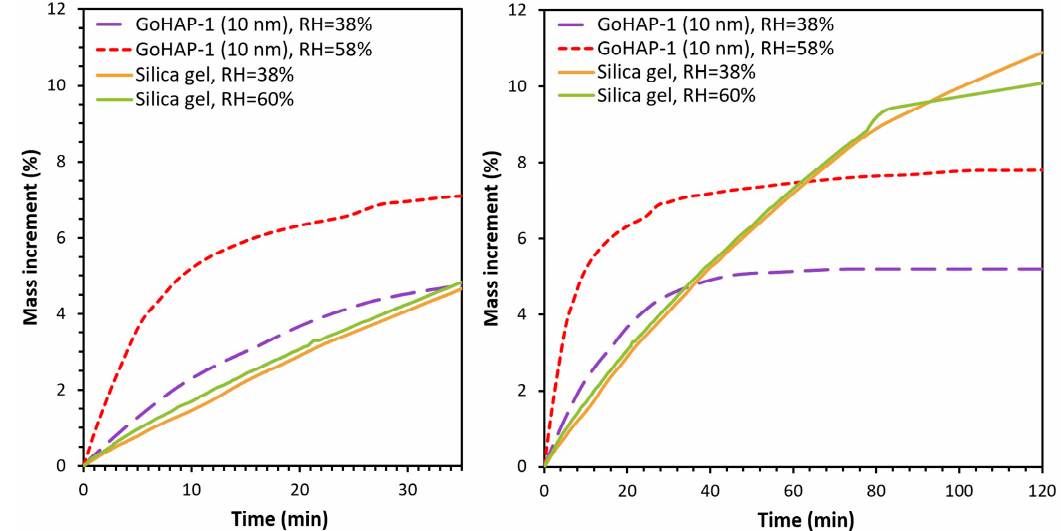
Figure 7. Kinetic curves of water adsorption on GoHAP-1 (10 nm) and Silica gel.